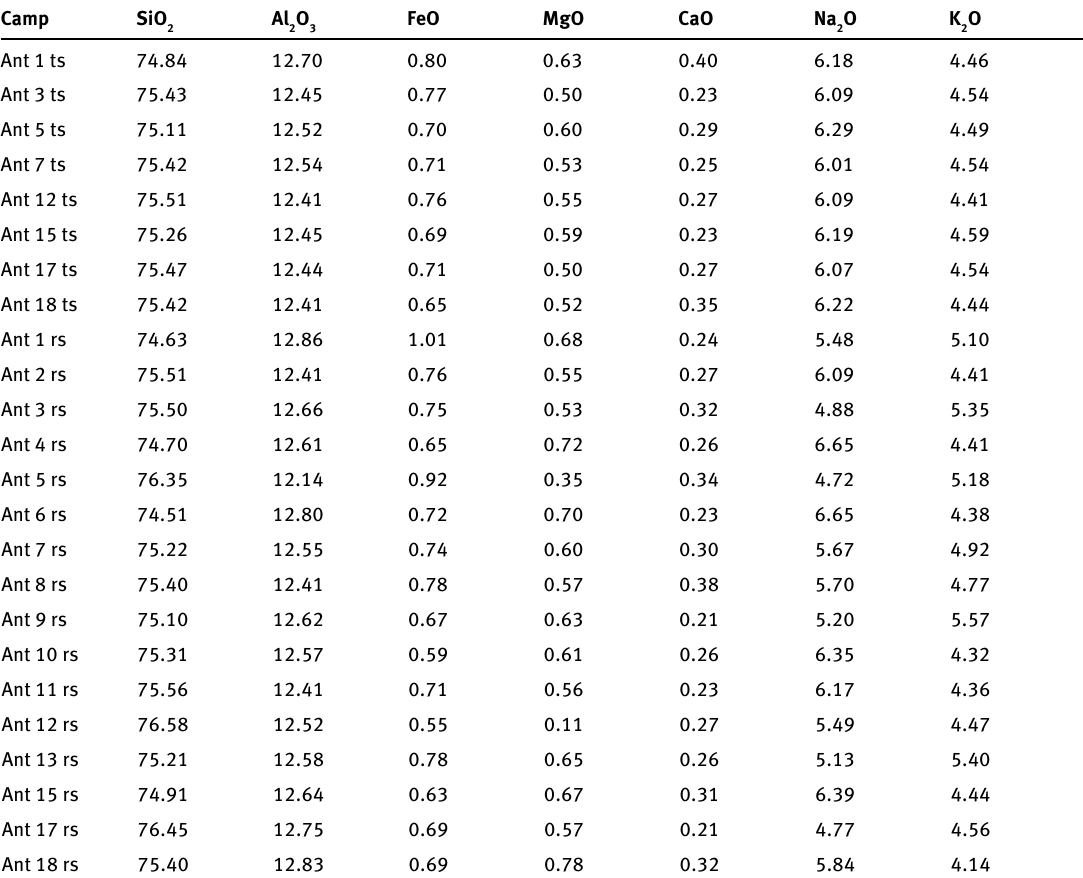
Table 4. SEM-EDS microanalyses on thin sections (ts) and raw surfaces (rs) of obsidian glass; each value reported in the table represents the mean of three different determinations.